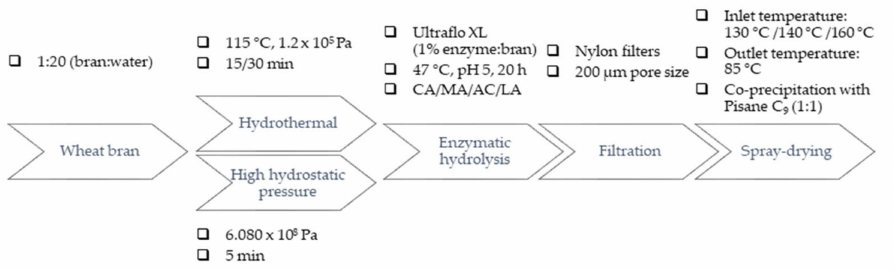
Figure 1. Processing route and operating conditions for the release of phenolic compounds and functionalization of WB. Abbreviations: citric acid (CA); malic acid (MA); acetic acid (AC); lactic acid